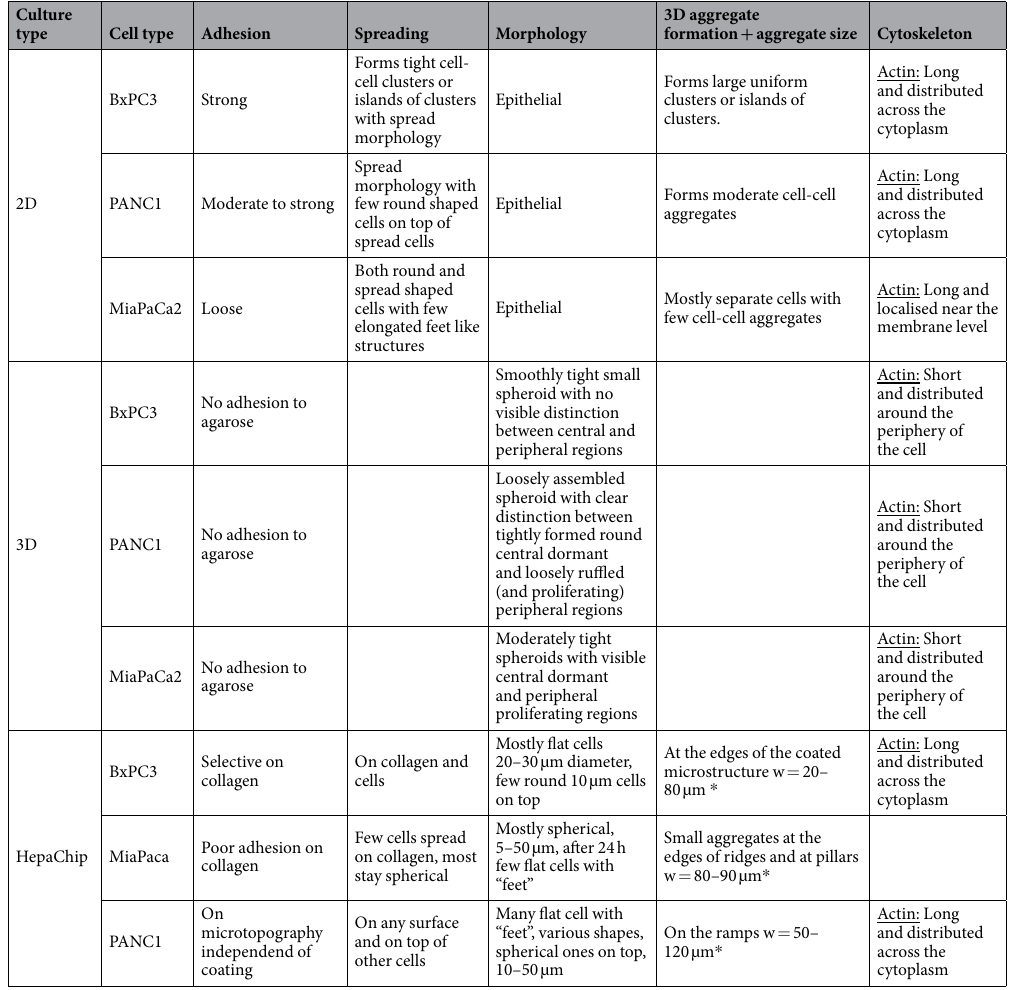
(2) PANC1 : during DEP PANC1 cells showed less adhesion to collagen coated areas but tended to slide over the surface before adhering. They were incubated for 10 to 15 min in DEP medium and left to sink onto the micro structured surface before the DEP medium was exchanged for culture medium. After that, PANC1 adhered everywhere in the chip, on collagen coating as well as on pluronic coated ramps of the ridges (Fig. 4B-0), on chan- nel walls and on gold electrodes. They spread on any of these surfaces and grew one on top of others (Fig. 4B-1 to B-6). In order to demonstrate the cell growth inside the 3D microstructure, Fig. 4B-6 was taken in two focal planes: that of the channel (left) as well as that of the collagen coated ridge (right). It shows that PANC1 also formed small aggregates on any of these surfaces after 6 days of cell culture. Overall, PANC1 cells behave inside the chip as a spheroid forming type. Actin stained with Phalloidin extended over the entire cytoplasm of both BxPC3 and PANC1 cells cultivated in the chip. As expected, it appeared denser along the cell membrane (Fig. 4D and E). PANC1 showed additional short actin filaments that extend from the membrane both into the cell and outside, a sign of the maintenance of their pro-migratory, cancerous features, even when cultured on the chip. The morphological and functional features of the three cell lines cultured as 2D, 3D and inside the chip are sum- marised in Table 1. Finally, we tested whether the microfluidic chip could be a useful device for testing drugs in PDAC cells. In particular, we tested the effects of Cisplatin, a widely used drug for many cancer types including PDAC, on PANC1 cells. Cisplatin exerted cytotoxic activity on PANC1, with IC 50 values of 3.25 ± 0.2 μ M (n = 2) and 14.6 ± 1.6 μ M (n = 2) in 2D and 3D cultures, respectively. In 3D cultures 100 μ M Cisplatin caused a decrease in cell viability (roughly 80%) after 72 h of incubation, and caused the spheroids to disaggregate after 72 h of treatment (Fig. 5B). We also tested the effects of Cisplatin in vivo , in immunocompromised mice subcutaneously injected with PANC1 cells, at 10 mg/kg 31 . As expected, this Cisplatin dose fully blocked tumour growth after 10